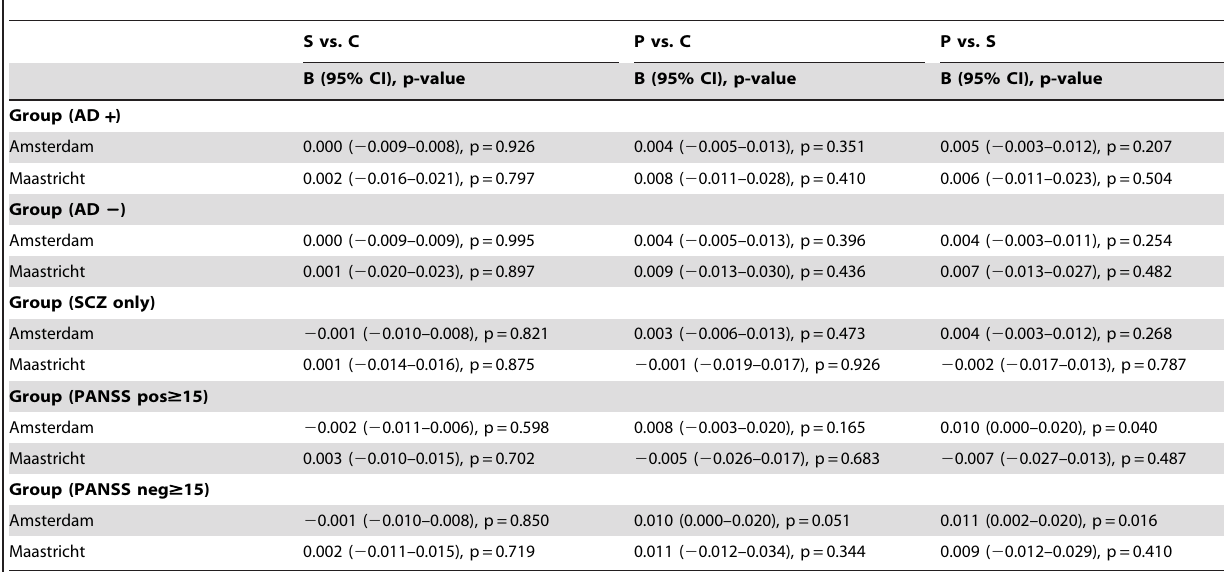
Table 2. Associations between group and